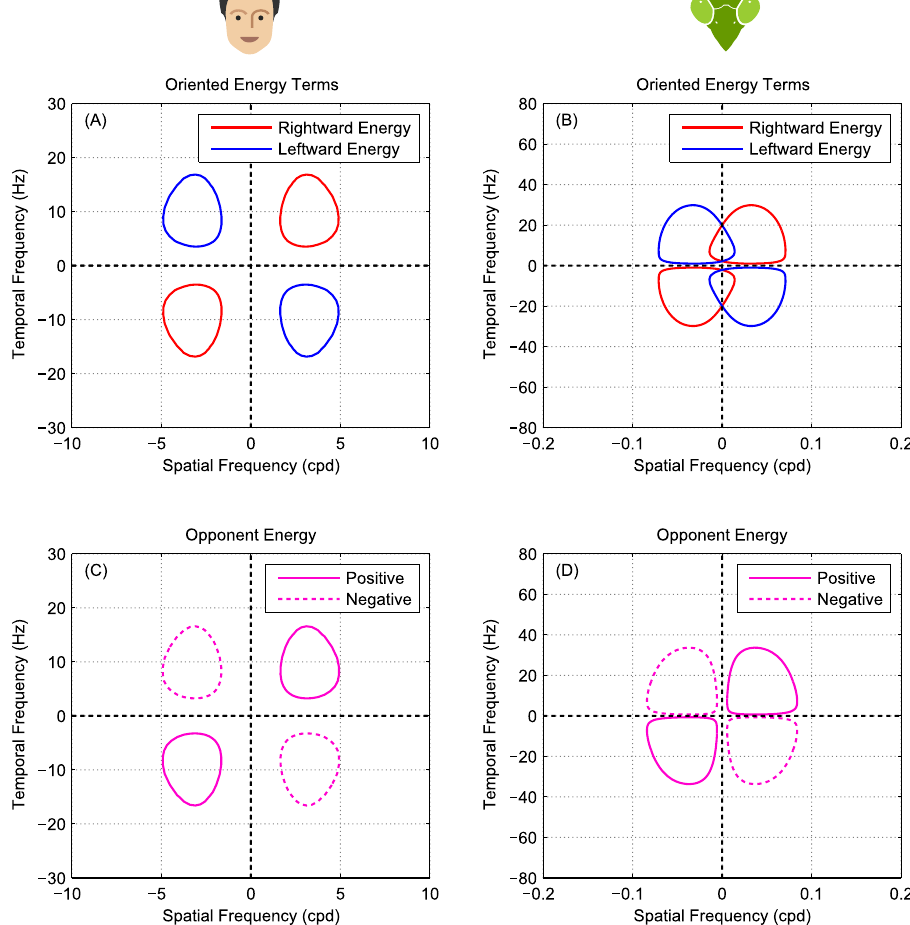
Figure 2. Spatiotemporal filter and opponent energy tuning in an opponent motion model. ( A , B ) Fourier spectra of rightward and leftward energies (( A + B ′ ) 2 + ( A ′ − B ) 2 , Equation 6, and ( A − B ′ ) 2 + ( A ′ + B ) 2 , Equation 7) for example mammalian and insect opponent energy motion detectors (see Methods for details, Equations 18–22). The colored lines in each plot are 0.25 sensitivity contours. The Fourier spectra of leftward and rightward energies are very similar to the model’s filters in each case: spatially bandpass in mammals and low-pass in insects. ( C , D ) Opponent energy, AB ′ − A ′ B , computed as the difference between rightward and leftward energies. In mammals, rightward and leftward responses do not overlap because the spatial filter are band-pass (panel A). In insects, the low-pass spatial filters cause an overlap between rightward and leftward responses (panel B) but this overlap is canceled at the opponency stage making opponent energy insensitive to low spatial frequencies (panel